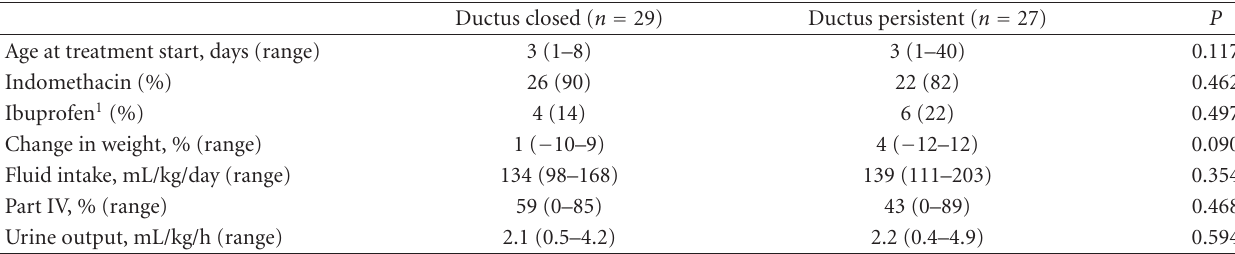
Table 3: Treatment characteristics.